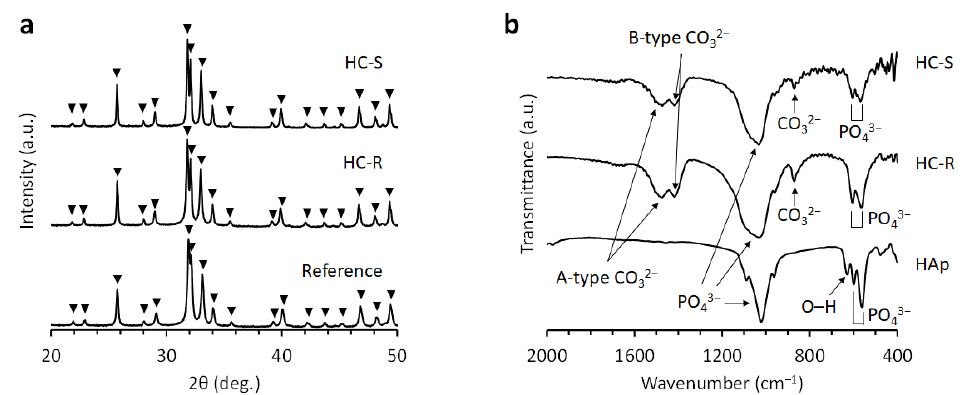
Figure 2. ( a ) X-ray diffraction patterns of honeycomb scaffolds with square channels (HC-S) and honeycomb scaffolds with rectangle channels (HC-R). Commercial carbonate apatite was used as a reference. ( b ) Fourier transform infrared (FT-IR) spectra of HC-S, HC-R, and hydroxyapatite (HAp).